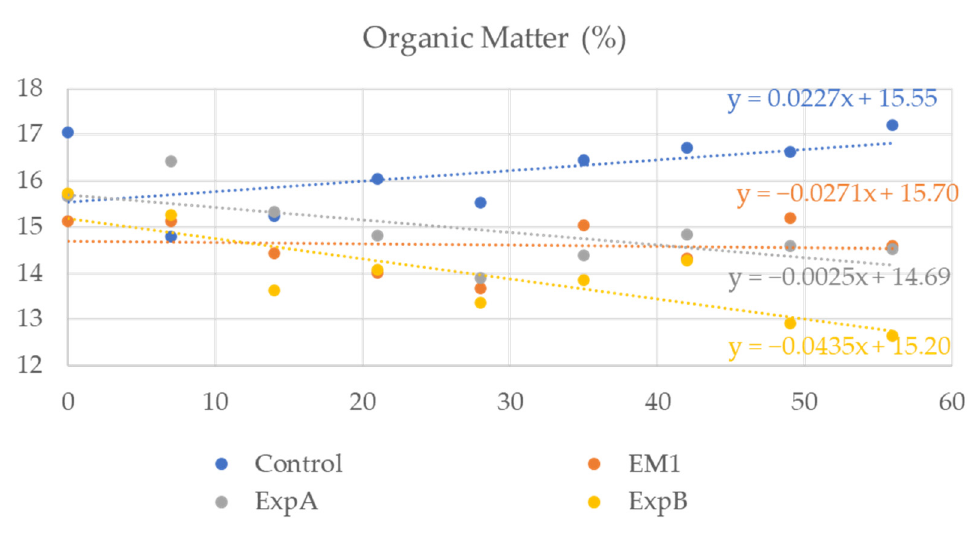
Figure 5. Organic matter content in the soil over the two-month experimental period in response to the untreated control, EM-1, ExpA and ExpB.